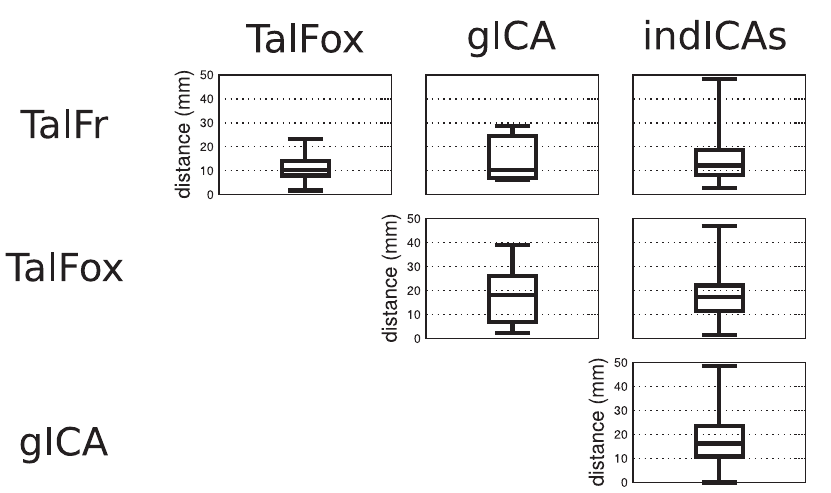
Figure 3. Distance between ROI centers according to the four ROI selection methods. The bottom and top of the box are the 25th and 75th percentile (the lower and upper quartiles, respectively), and the band in the box is the 50th percentile (median); whiskers represent minimum and maximum values.